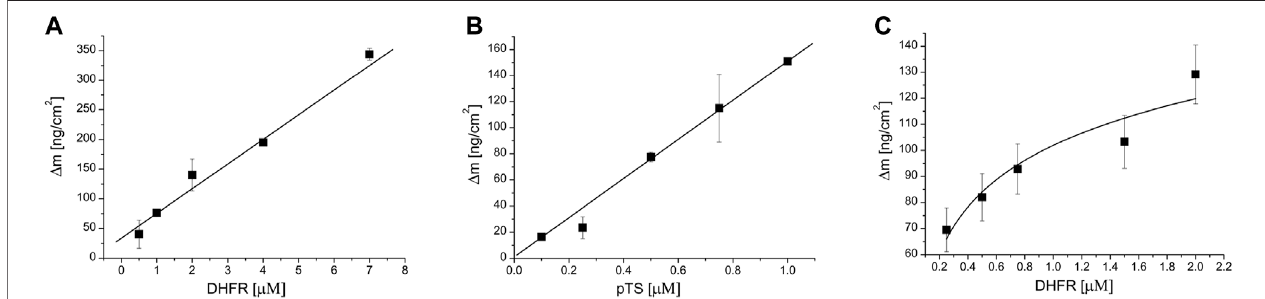
FIGURE 6 | Langmuir isotherm showing the dependence of the weight change on the QCM-D sensor surface on ligand concentration. SHMT was immobilized on the sensor surface, whereas increasing concentrations of indicated thymidylate synthesis cycle enzymes were introduced into the measuring chamber as ligand